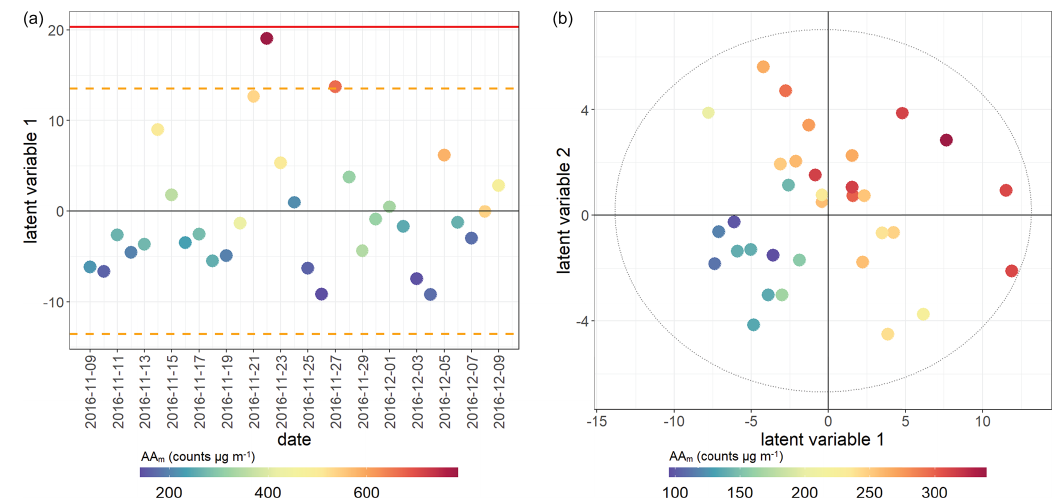
Figure 8. PLSR score plot for AA m assay. Model performance parameters given in Table 2. (a) Winter samples; (b) summer samples. Points coloured by overall AA assay response for both seasons. Red bar indicates 2 × SD for all scores; orange dotted line indicates 1 × SD for all scores. Models which have only one latent variable have the x axis replaced by date for easier visualisation.